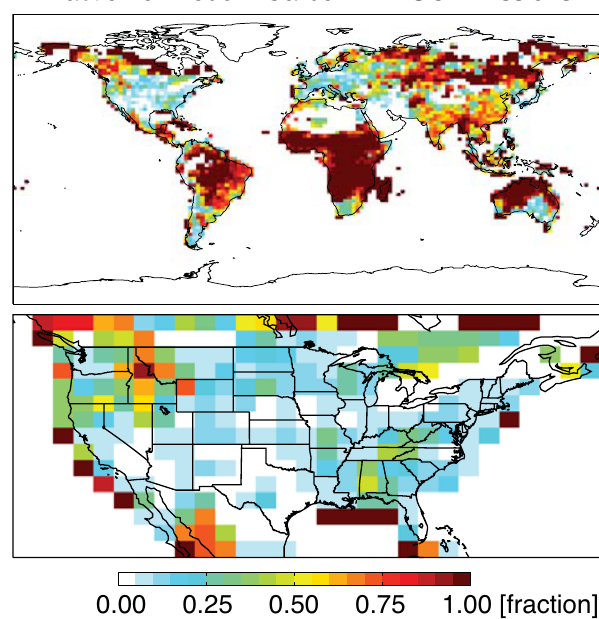
Fig. 12. Fraction of IVOC emissions from modern carbon: (Biomass + Biofuel) / (Biomass + Biofuel + Anthropogenic). Note that the high contribution of modern carbon just of the coast of the US (such as over the Gulf of Mexico) results from small, but non- zero emissions from biofuel burning. Biofuel emissions occur in these location as a result of degredation of the emission inventory as it is regrided from 0 . 25 ◦ × 0 . 25 ◦ to 1 ◦ × 1 ◦ and then 2 ◦ × 2 . 5 ◦ or 4 ◦ × 5 ◦ horizontal resolution for use in